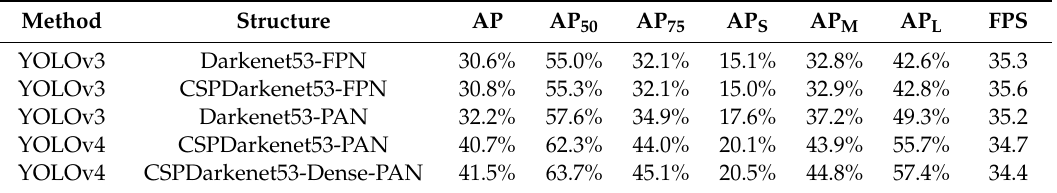
Table 1. Variation in network performance due to different blocks.